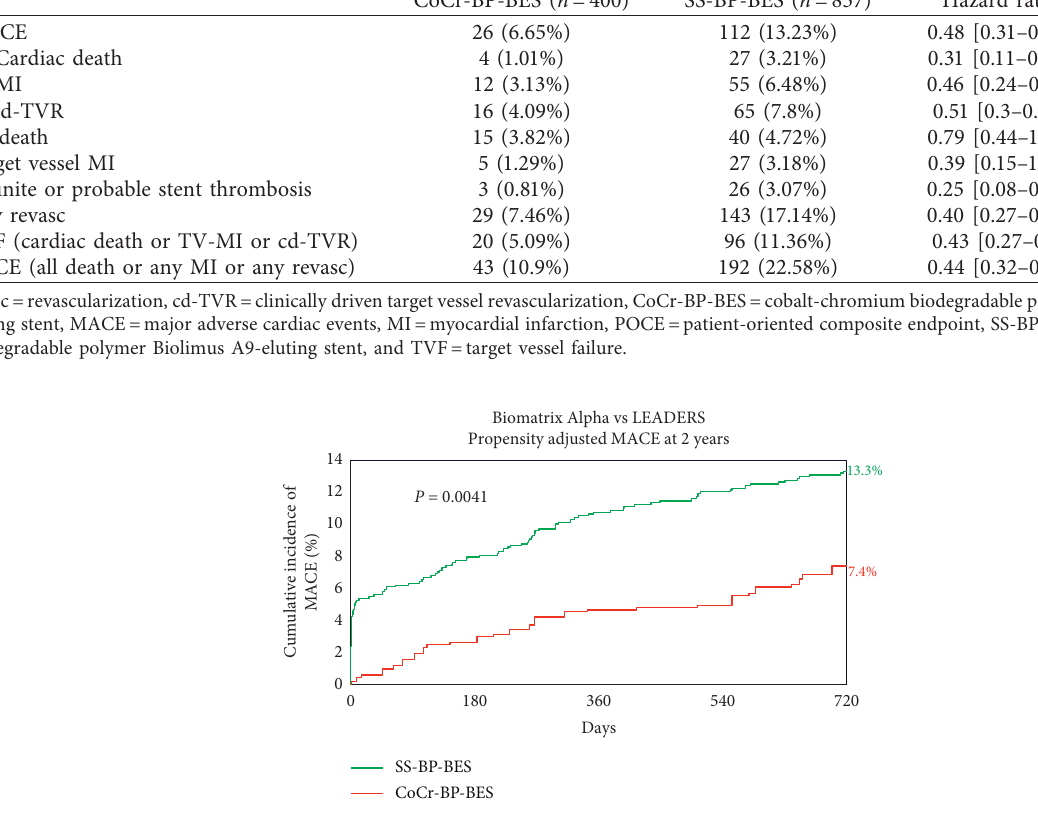
Figure 2: Propensity-adjusted MACE at 2 years. CoCr-BP-BES � cobalt-chromium biodegradable polymer Biolimus A9-eluting stent,